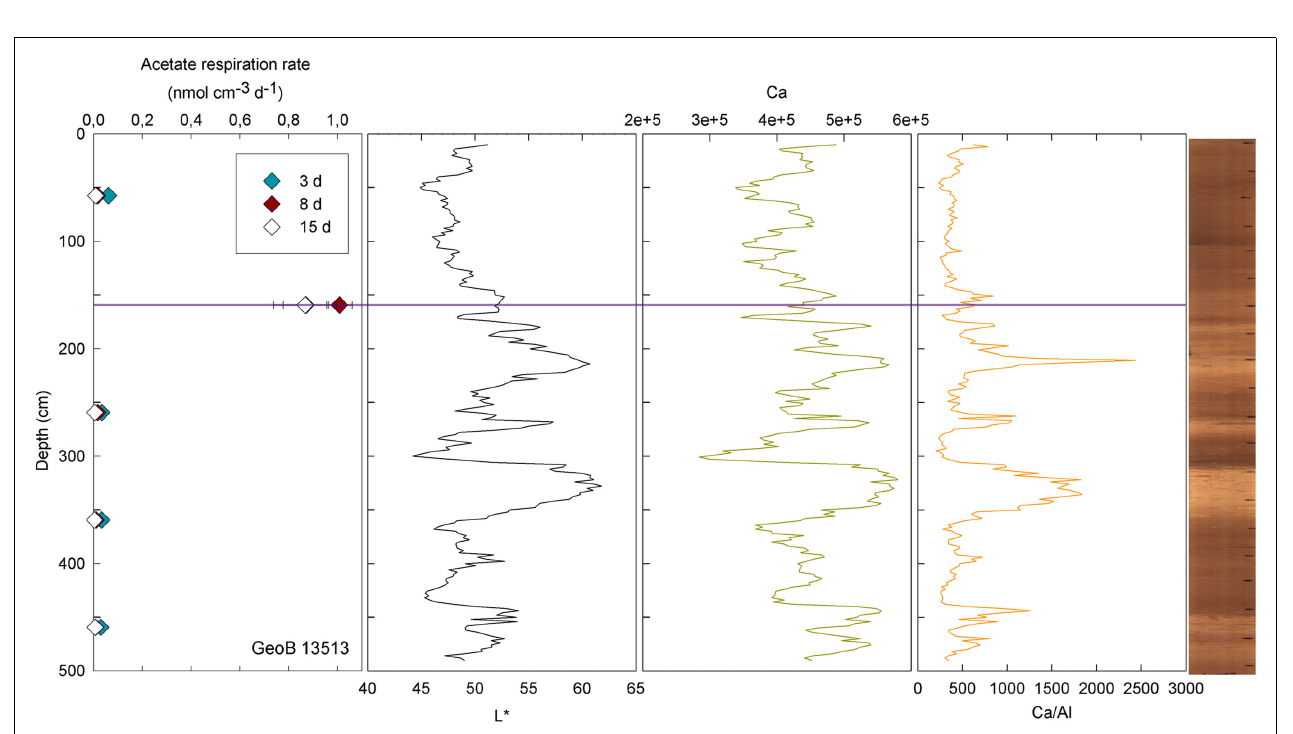
FIGURE 4 | GeoB 13507 linked activities and lithological features. Yellow lines denote sandy layers; purple lines denote depths of greater potential acetate turnover. Samples were taken at 47.5, 125.5, 225.5, 300.5, 325.5, 425.5, 522.5, 622.5, 718, 722.5, and 822.5cm.